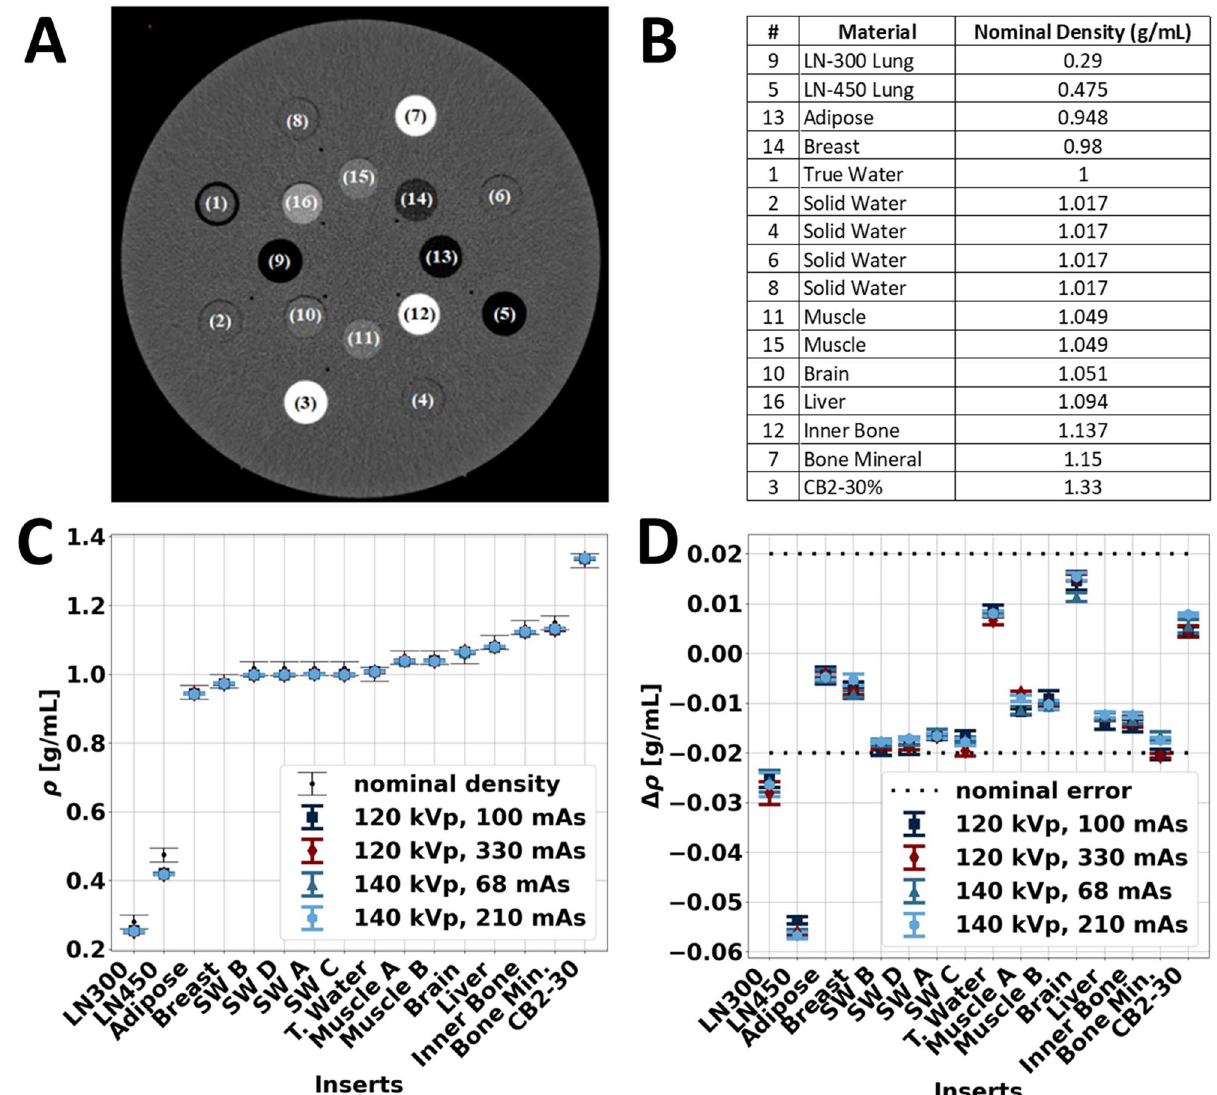
Figure 3. Parametrized AM-PD model validation with DECT measurements of tissue mimicking inserts. A tissue characterization phantom ( A ) was scanned with multiple tissue mimicking inserts with a range of nominal density values ( B ). DECT measurements of VMI 70 keV and Z eff were acquired at two different kVps and doses to examine the effect of scan parameters on physical density quantifications ( C ). Except for the two lung inserts (LN450 and LN300), physical density values were within the nominal error of ± 0.02 g/ml (black dotted lines, D ) and did not vary with different scan